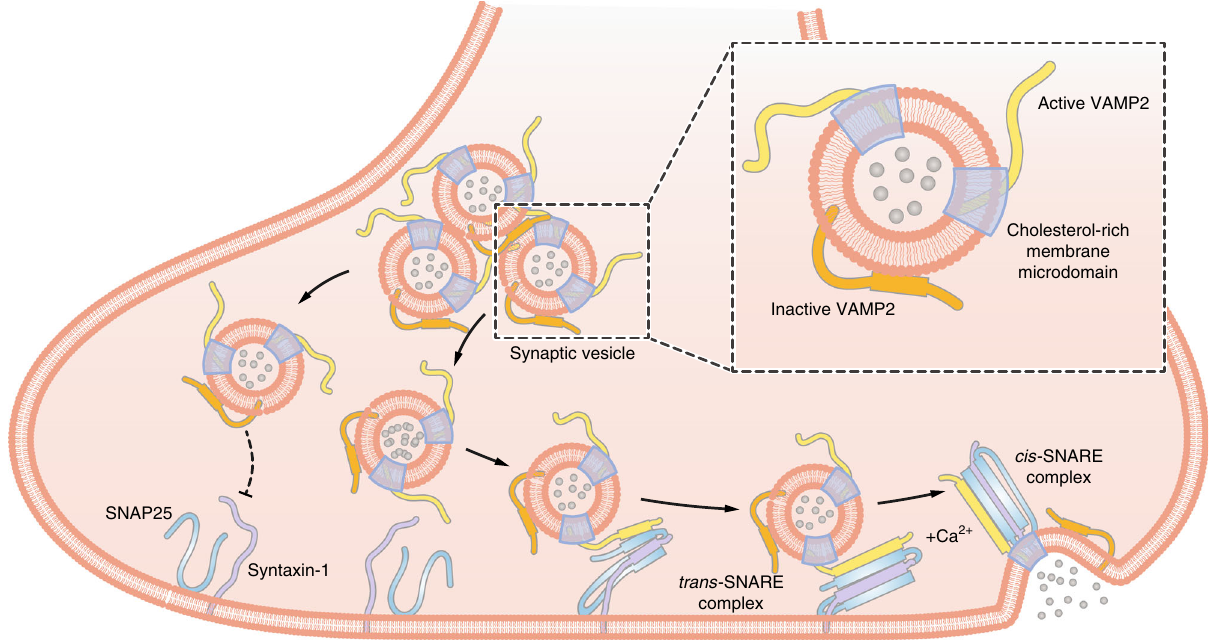
Fig. 5 Hypothetic models of VAMP2 conformations and engagement in SNARE complex assembly for neurotransmitter release. The extravesicular domain of VAMP2 adopts distinctive conformations in different membrane regions. On the cholesterol-rich microdomains, it is less associated with SV membrane and thus more active to engage in calcium-evoked SNARE assembly and neurotransmitter release. In contrast, in other regions of SV membrane, it tends to hibernate on the membrane with an increased content of α -helical conformation which is relatively inactive in SNARE